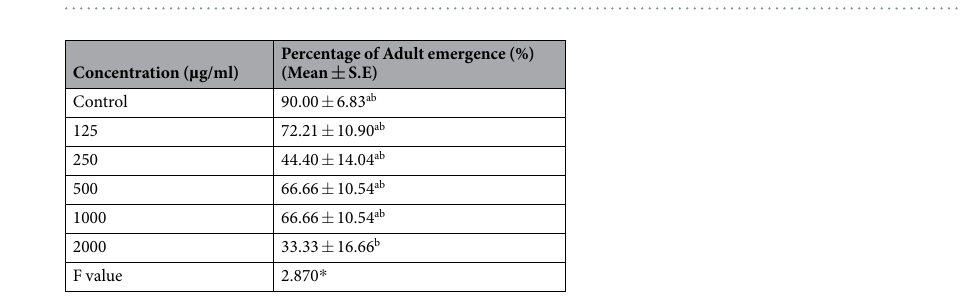
Table 5 revealed the effect